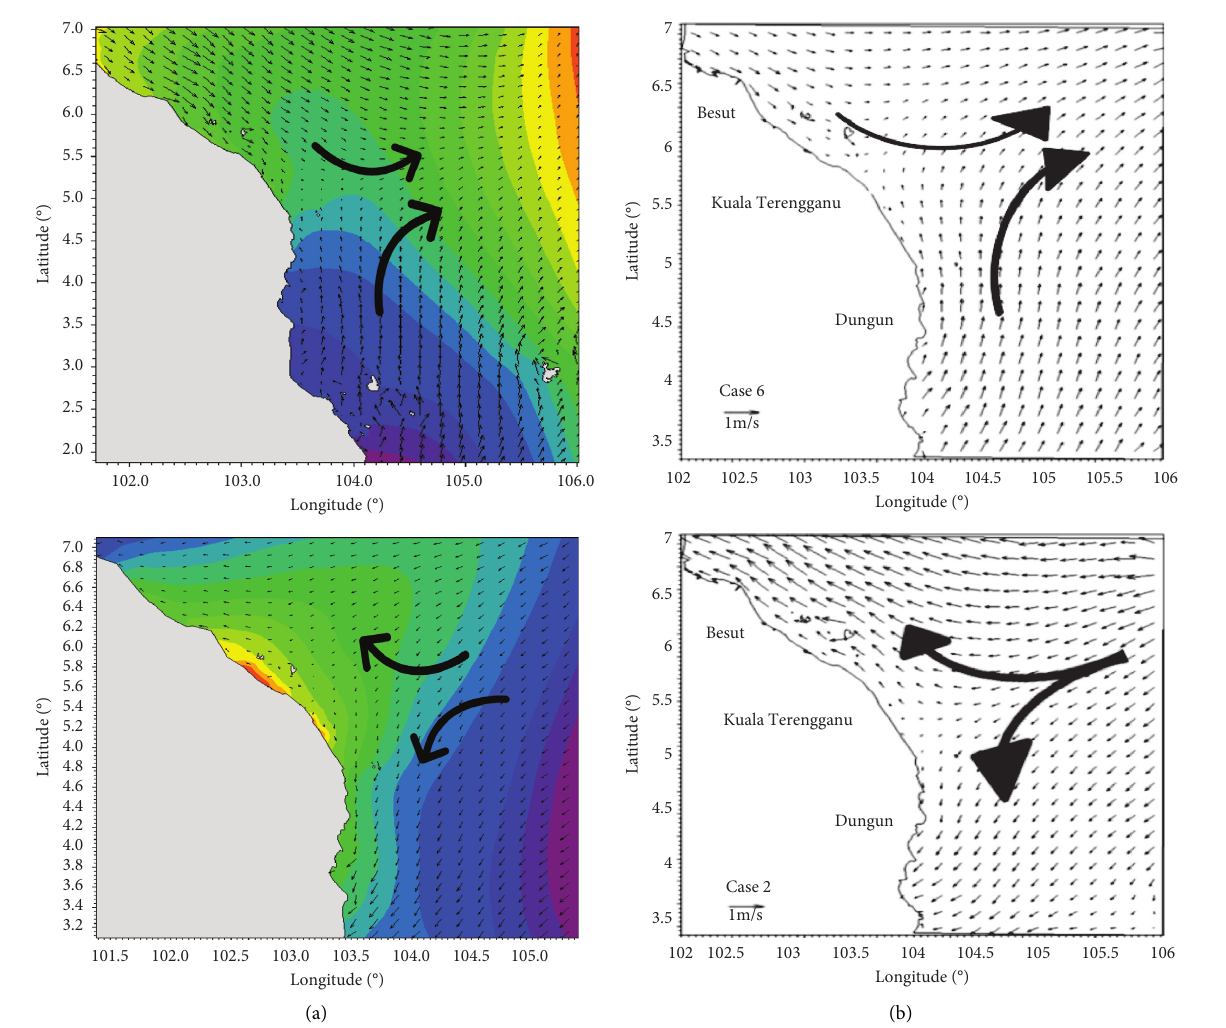
Figure 3: Comparison of major current direction for (a) present numerical model and (b) the model of Daud et al. [8].